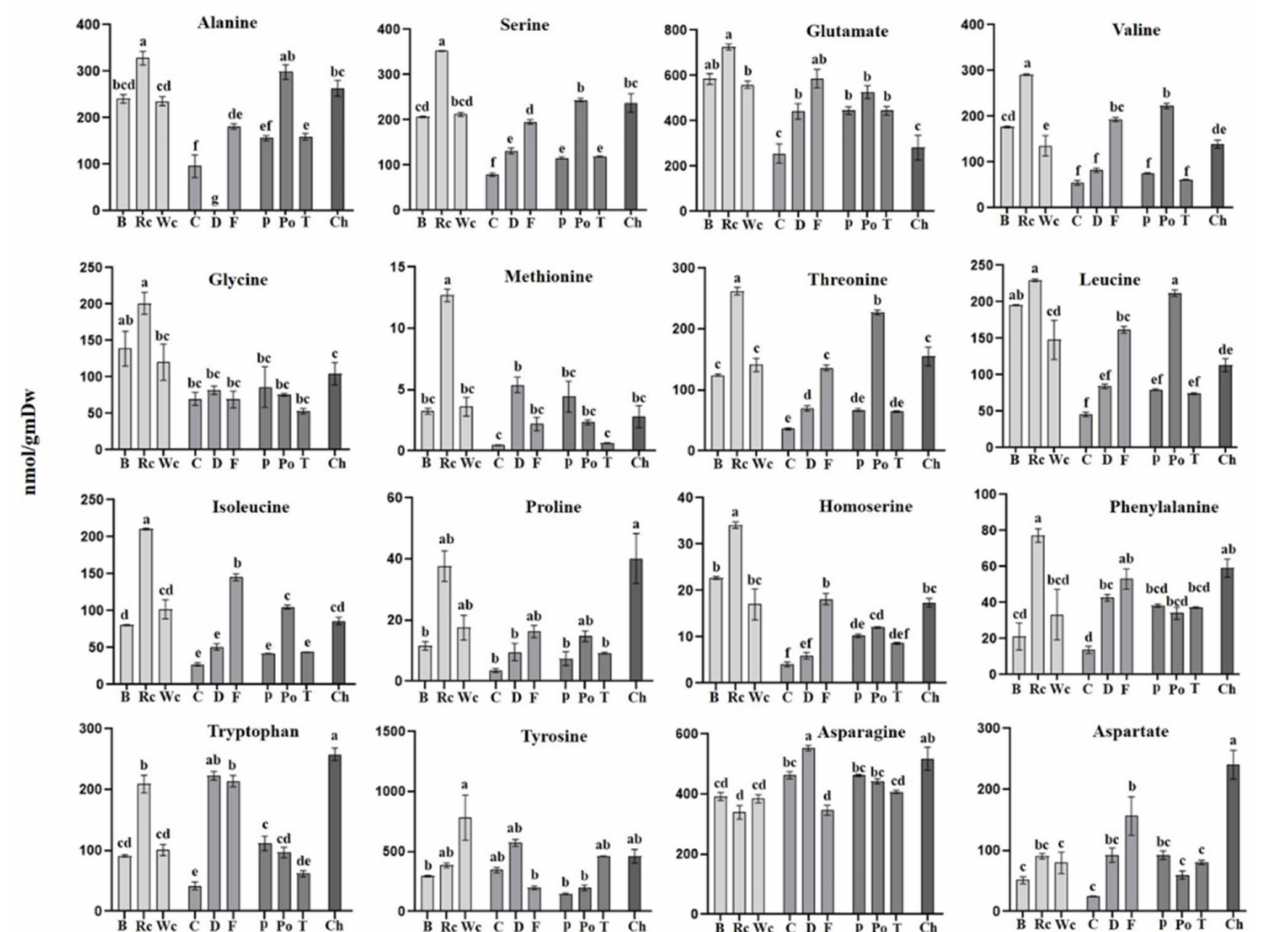
Figure 7. The levels of individual amino acids of P. aegyptiaca grown on 10 host plants as detected by using GC-MS. Values are normalized to the norleucine internal standard. Levels of different amino acids accumulated in P. aegyptiaca grown on 10 host plants collected from Broccoli (B), Red cabbage (Rc), White cabbage (Wc), Carrot (C), Dill plant (D), Fennel bulbs (F), Pepper (P), Potato (Po), Tomato (T) and Chickpea (Ch). Data shown are means ± SE of four replicates for each plant type. Significance is calculated according to the Turkey Kramer HSD test ( p < 0.05) and is denoted by different lowercase